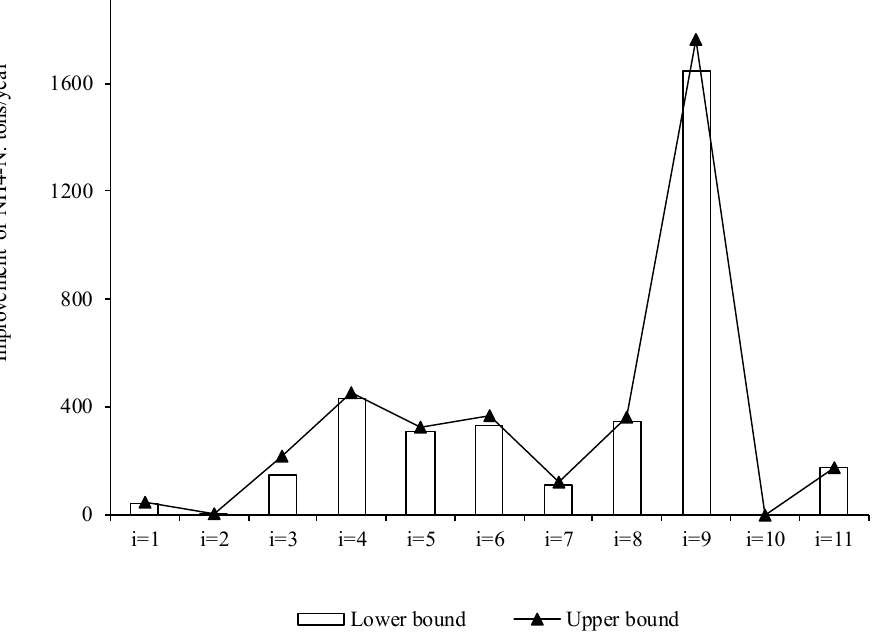
Figure 10. Improvements in NH 4 -N carrying capacity for the Yinma River.